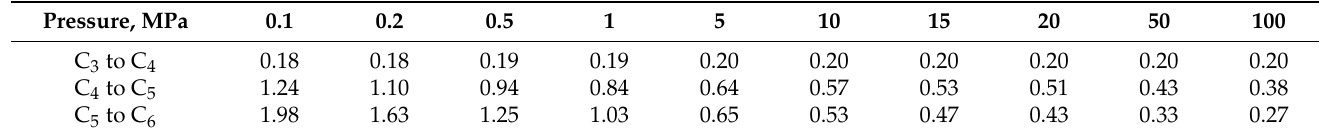
Table 22. ASF α value as a function of pressure for the gaseous hydrocarbons (Table